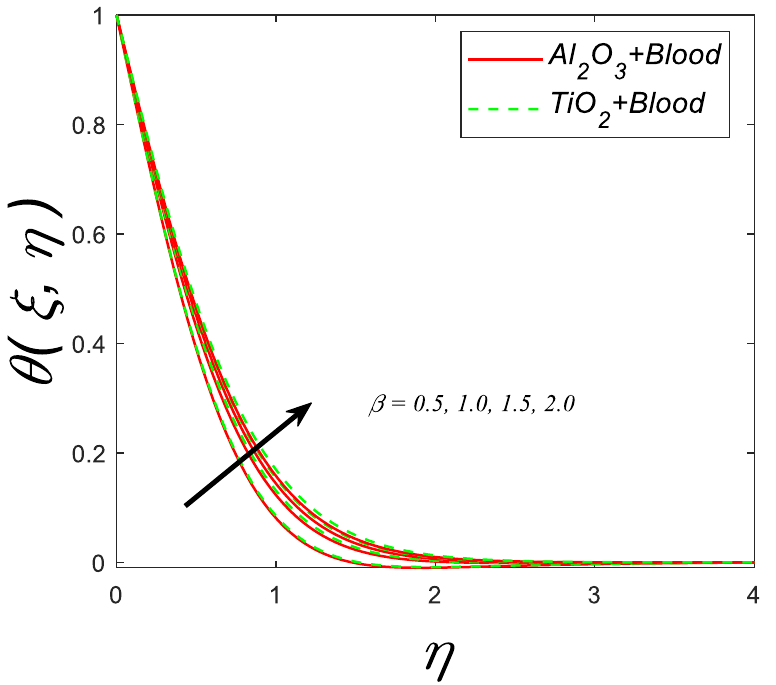
, 𝜉 = 0.1,𝑅𝑑 = , ξ = 0.1, Rd = 0.1, 3 3